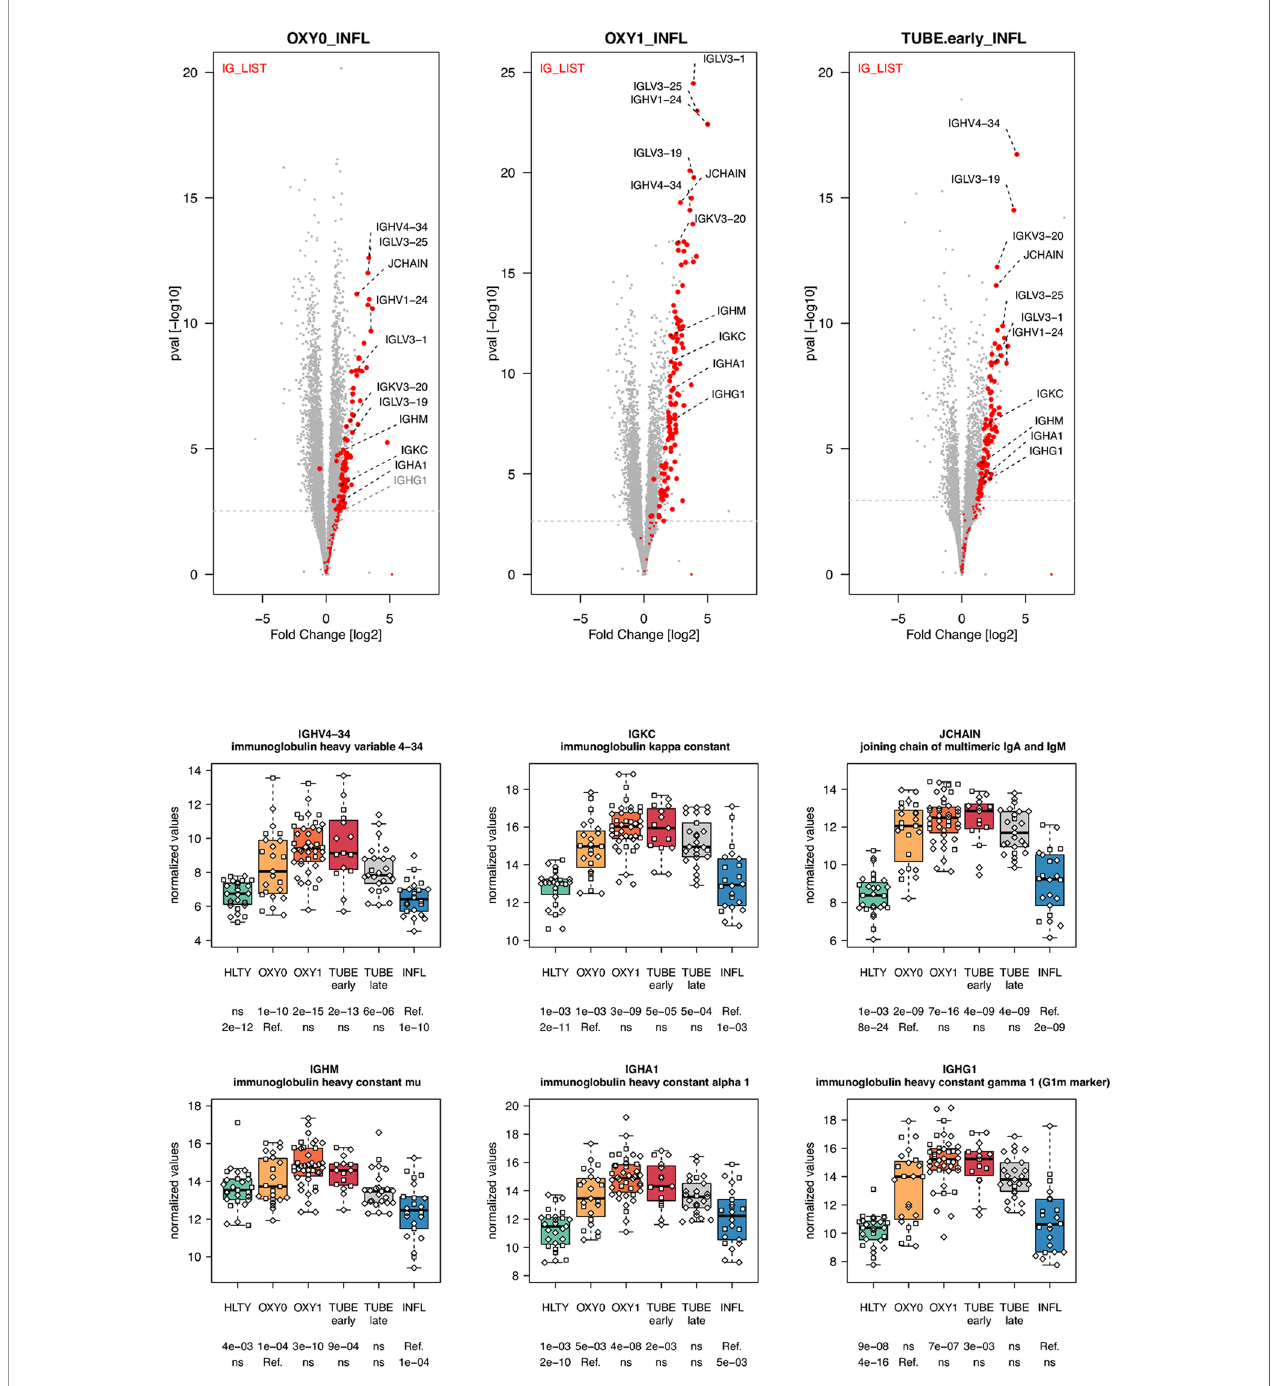
FIGURE 9 | Differentially expressed immunoglobulin encoding genes. Upper panel: for each comparison indicated in the volcano plot header, the distribution of log2 fold changes and P-values of all detected genes is shown as gray dots. Red dots indicate immunoglobulin encoding genes. Genes ’ sets are selected from different GO, REACTOME and/or KEGG pathways (see Supplementary Table 2 ). The dotted horizontal gray line indicates the limit under which – log10(P-value) becomes non signi fi cant once adjusted for multiple testing (adjusted P > 0.01). Lower panel shows detailed expression levels of selected immunoglobulin encoding genes in the different groups of patients. Groups used for comparisons include SARS-Cov-2 infected patients (no oxygen support [OXY0], oxygen support [OXY1], intubation with sampling within 7 days [TUBE early] or >7 days [TUBE late] after hospital admission), In fl uenza virus [INFL] infected patients and non-infected controls [HLTY]. Adjusted P-values of pairwise comparisons between a reference group (Ref.) and another group are indicated below the x axis. Ref. is taken as [INFL] and [OXY0] on the fi rst and second line,